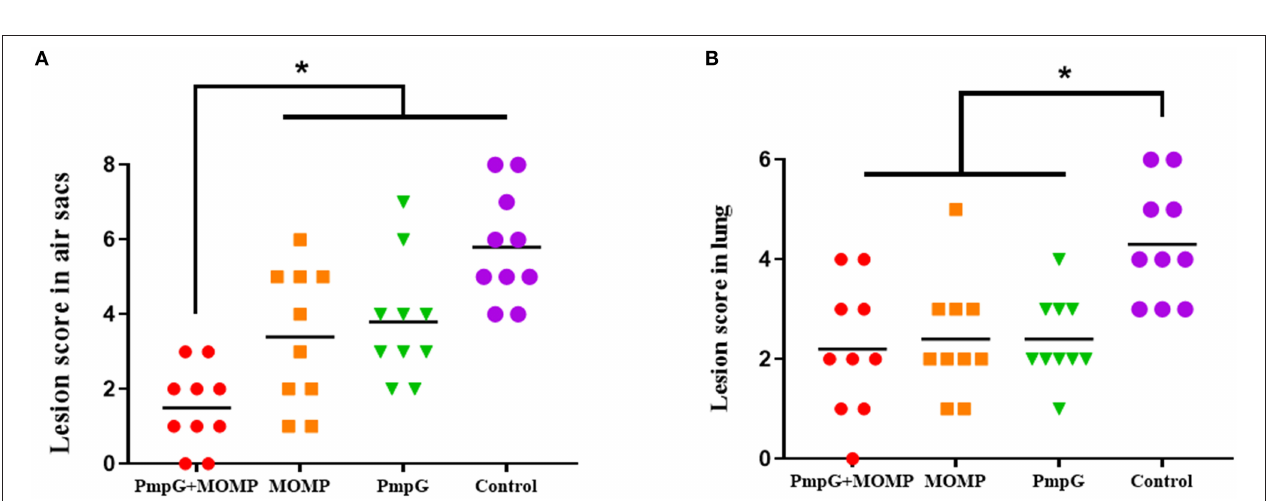
FIGURE 4 | Lesions of air sacs and lungs post Chlamydia challenge in SPF chickens. (A) Lesions of air sacs were dramatically reduced in the PmpGs + MOMP group compared with the PmpGs group alone and the MOMP group ( p < 0.05). (B) No statistical difference in lung lesions was determined among the three tested groups. The differences were analyzed by ANOVA (* p <